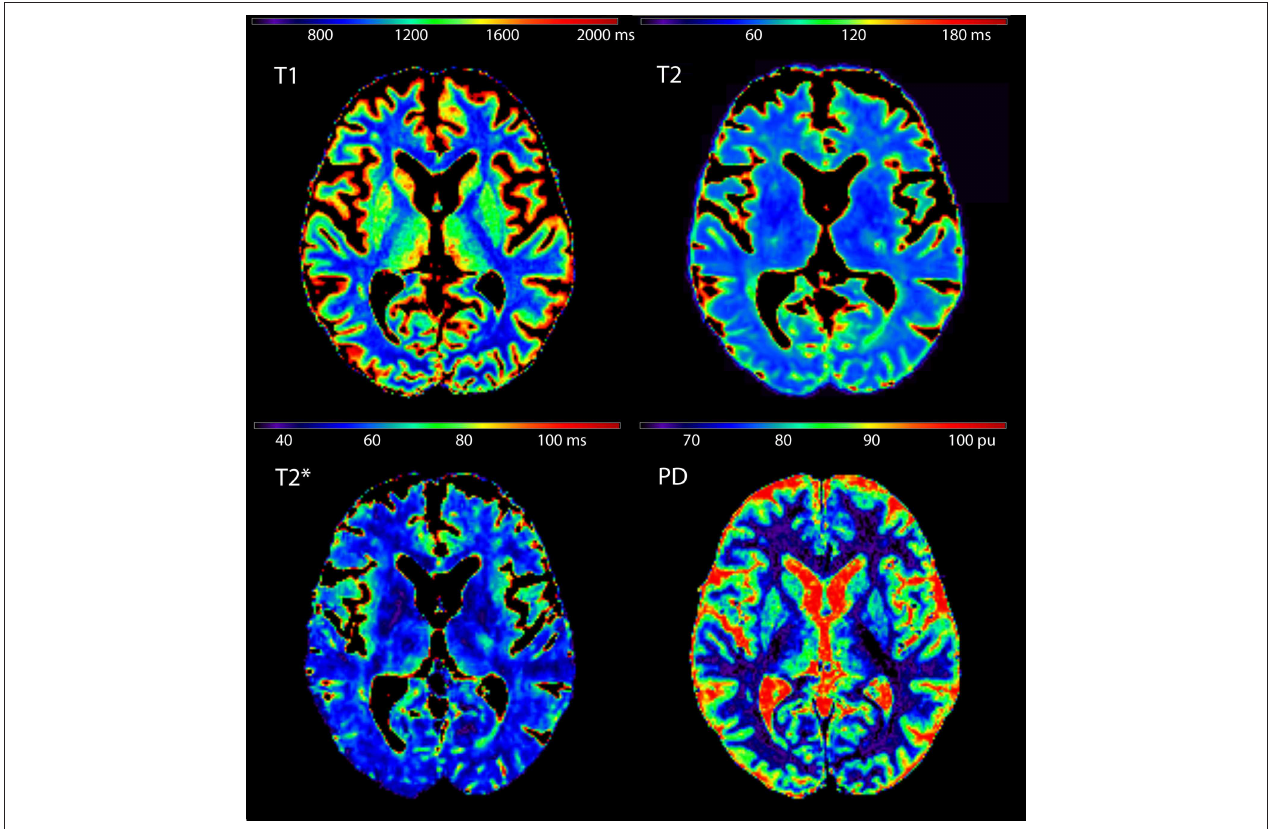
FIGURE 2 | Quantitative T 1 , T 2 , T * 2 , and proton density maps shown for the same subject presented in Figure 1 ( z =